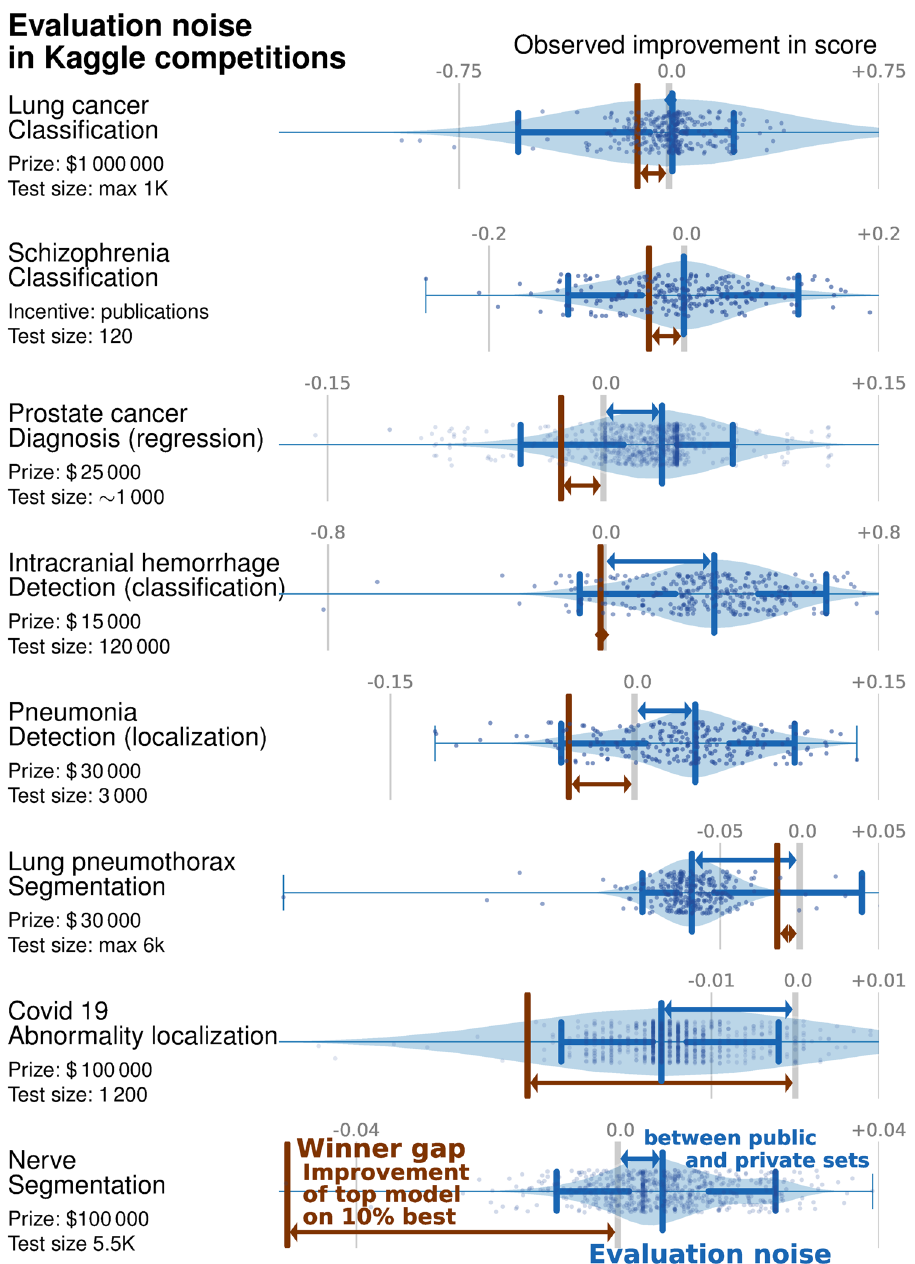
Fig. 3 Kaggle challenges: shifts from public to private set compared to improvement across the top 10% models on eight medical- imaging challenges with signi fi cant incentives. The blue violin plot shows the evaluation noise — the distribution of differences between public and private leaderboards. A systematic shift between public and private set (positive means that the private leaderboard is better than the public leaderboard) indicates over fi tting or dataset bias. The width of this distribution shows how noisy the evaluation is, or how representative the public score is for the private score. The brown bar is the winner gap , the improvement between the top-most model (the winner) and the 10% best model. It is interesting to compare this improvement to the shift and width in the difference between the public and private sets: if the winner gap is smaller, the 10% best models reached diminishing returns and did not lead to a actual improvement on new